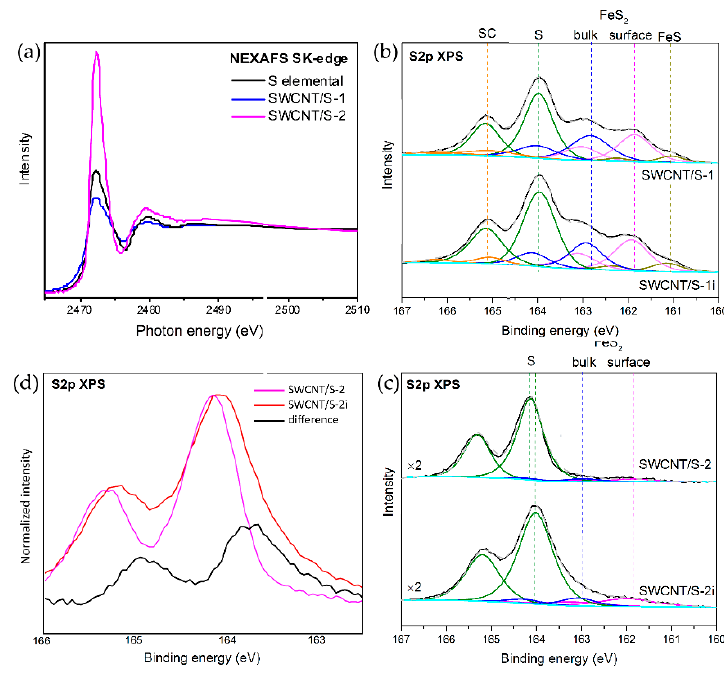
Figure 4. C K -edge NEXAFS ( a ) and C 1 s XPS ( b ) spectra of initial SWCNTs and sulfur-contained SWCNTs before and after illumination. The insert in ( a ) compares 𝜋 * resonances of the spectra normalized to the intensity of σ * resonances.